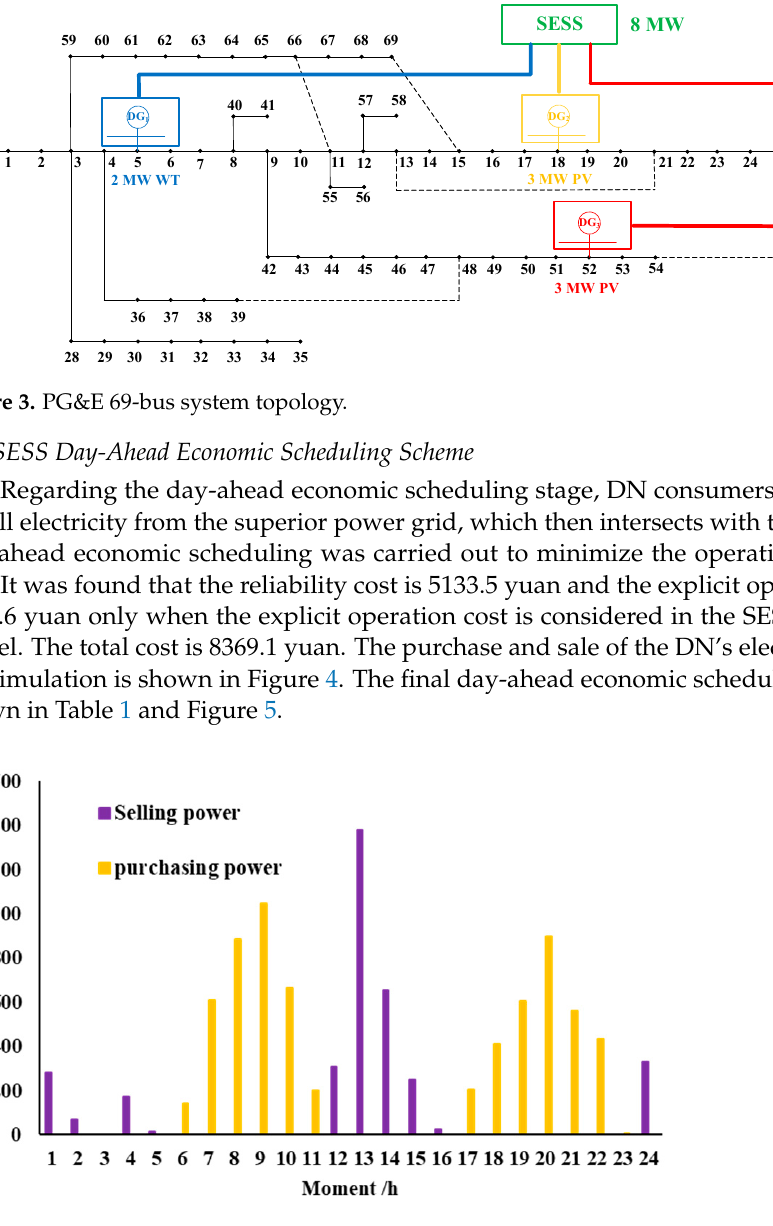
Figure 4. The purchase and sale of the DN’s electricity during the simulation. Table 1. Remaining electricity in SESS for each moment in day-ahead economic scheduling